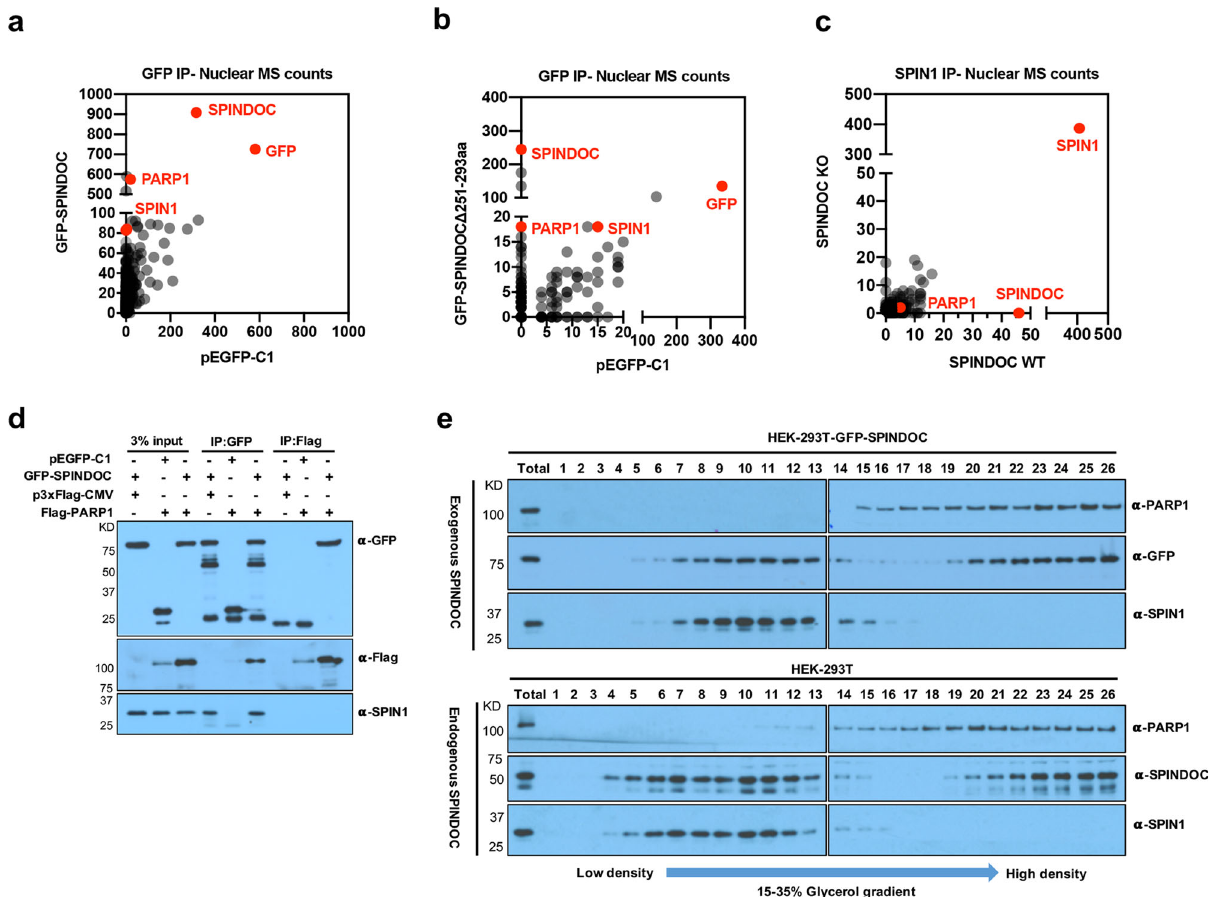
Fig. 1 SPINDOC is involved in two different complexes. a HEK293T cells were transfected with pEGFP-C1 vector and GFP-SPINDOC, 48 h later, cells were harvested and processed into cytoplasmic and nuclear fractions. Each fraction was immunoprecipitated by anti-GFP antibodies and subjected to MS analysis. Peptide spectral counts are presented as a scatterplot, and the empty vector group serves as a control. b HEK293T cells were transfected with pEGFP-C1 vector and GFP-SPINDOC Δ 251 – 293aa, and the same procedure as followed as in ( a ). c SPIN1 IP was performed from HEK293T-SPINDOC WT and KO cell lines and then analyzed by MS. d HEK293T cells were transfected with the indicated vectors, and incubated for 48 h. GFP IPs and Flag IPs were performed to evaluate the interactions between SPINDOC, PARP1, and SPIN1. The results were repeated three times independent experiments, shown as representative blots. e Lysates from HEK293T cells and HEK293T cells transfected with GFP-SPINDOC were centrifuged with 15~35% glycerol gradients and divided into 26 fractions from top to bottom (density from low to high). All samples were analyzed by Western blot, the “ Total ” is the original lysate prior to gradient centrifugation. The results were repeated three times independent experiments, shown as representative